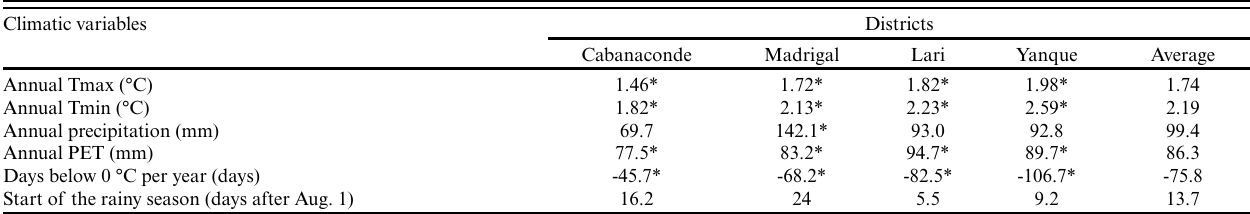
Values represent the total change for the period 1988 to 2017 based on the Sen’s slope trend analysis; * indicates that a statistically significant trend was found using Mann-Kendell analysis with a significance level of 0.05; Tmax = average daily maximum air temperature; Tmin = average daily minimum air temperature; PET = potential evapotranspiration.